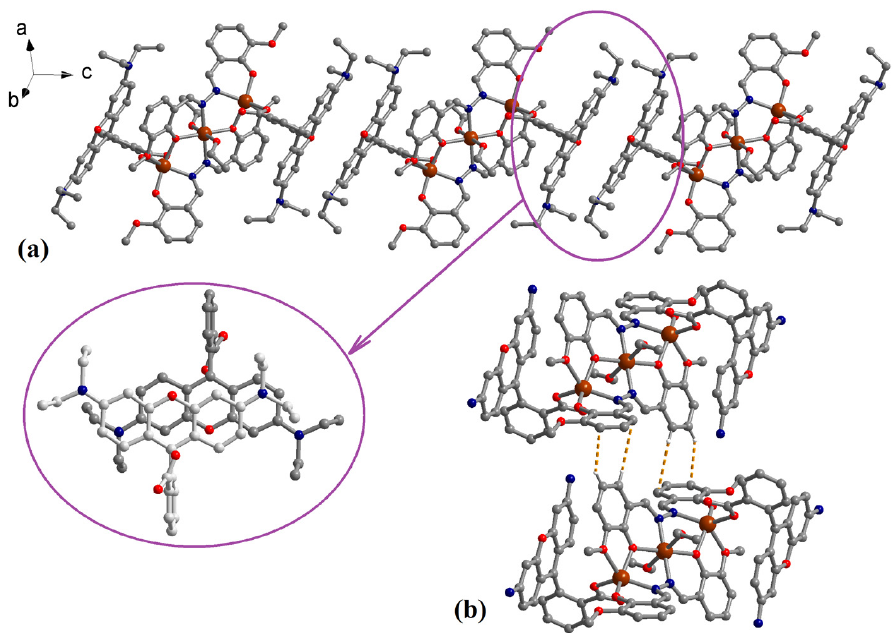
Figure 2. ( a ) Packing diagram in crystal 1 showing formation of supramolecular chains by π – π interactions between the RhB ligands and a detail with the xanthene fragments overlap, and ( b ) CH··· π interactions established between the molecules from neighbouring supramolecular chains. The hydrogen atoms and ethyl groups (in figure ( b )) were omitted for clarity.